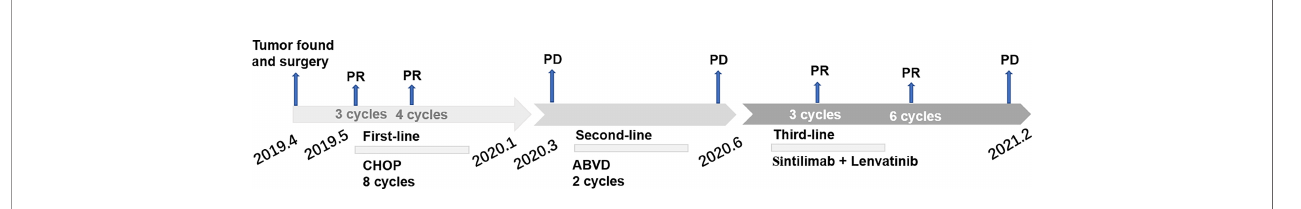
FIGURE 5 | Timeline scheme of major clinical event of the patient